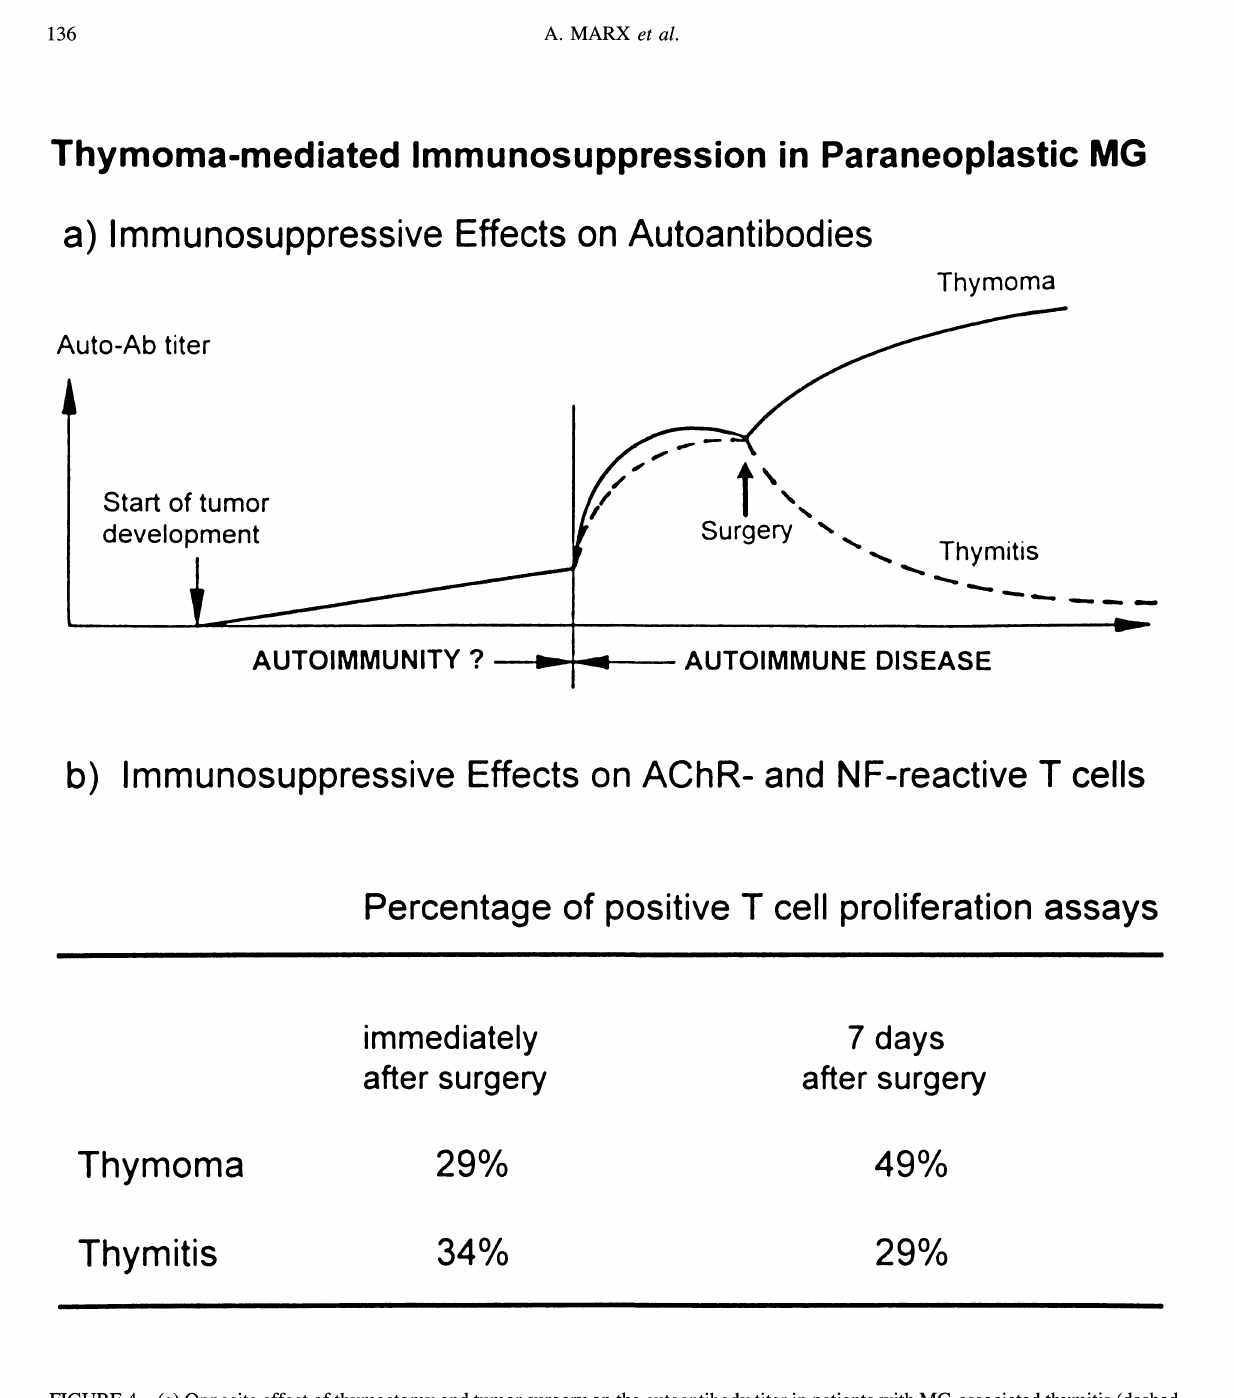
FIGURE 4 (a) Opposite effect of thymectomy and tumor surgery on the autoantibody titer in patients with MG-associated thymitis (dashed curve) and thymoma (solid curve). The rise in autoantibody titer is usually accompanied by deterioration ofthe clinical state (Somnier, 1994; Nix et al., 1997; Schalke et al., 1997). (b) Increased frequency of AChR and neurofilament-reactive T cells in the peripheral blood week after surgery in MG patients with mixed and cortical thymoma (n 9). The figures given indicate the percentage of positive wells